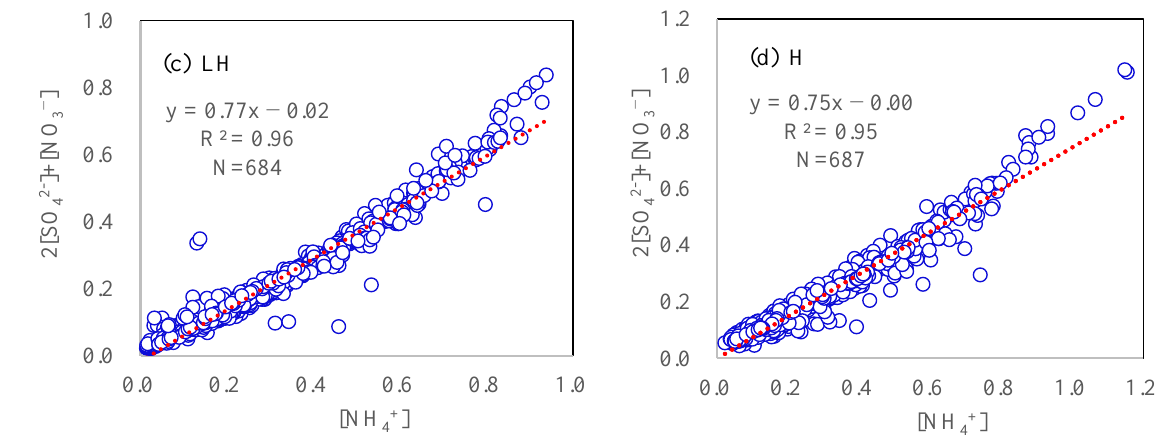
Figure 10. Scatter plots of 2[SO 4 2− ] + [NO 3 − ] vs. [NH 4+ ] (μmol/m 3 ) under the different photochemical activity levels in the summertime 2020 in Tianjin, China. ( a – d ) denotes the different photochemical activity levels of L, M, LH and H.